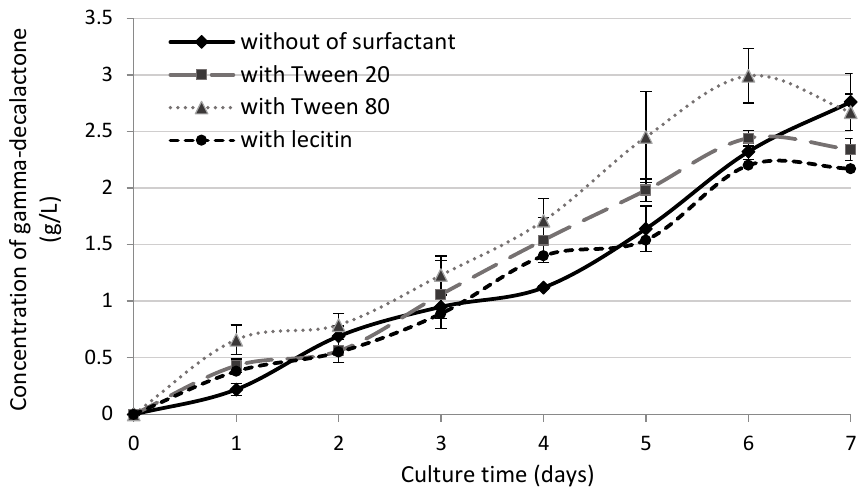
Figure 3. Effect of surfactant addition (5 g/L) on biotransformation of ricinoleic acid into GDL by yeast Yarrowia lipolytica .